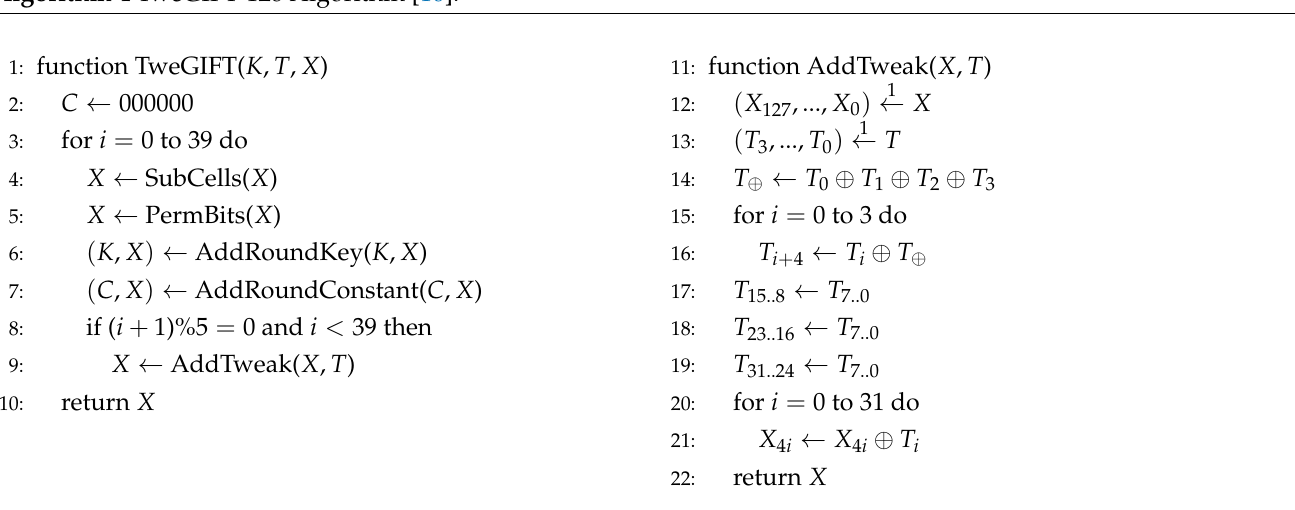
Algorithm 4 TweGIFT-128 Algorithm